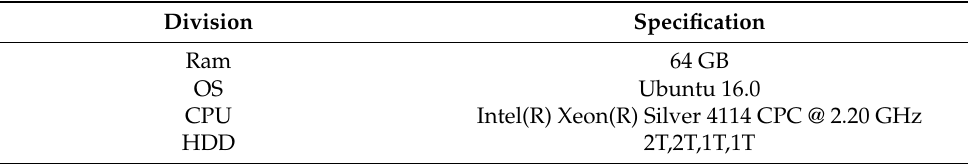
Table 7. Server specification for data storage with Hadoop ecosystem.